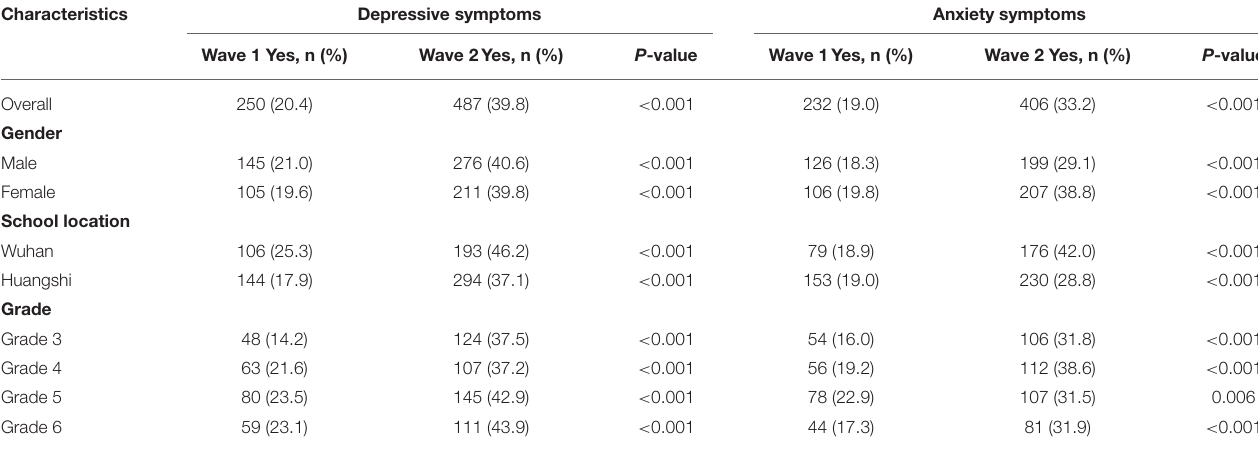
TABLE 3 | Change of psychological symptoms outcomes among children at two surveys.